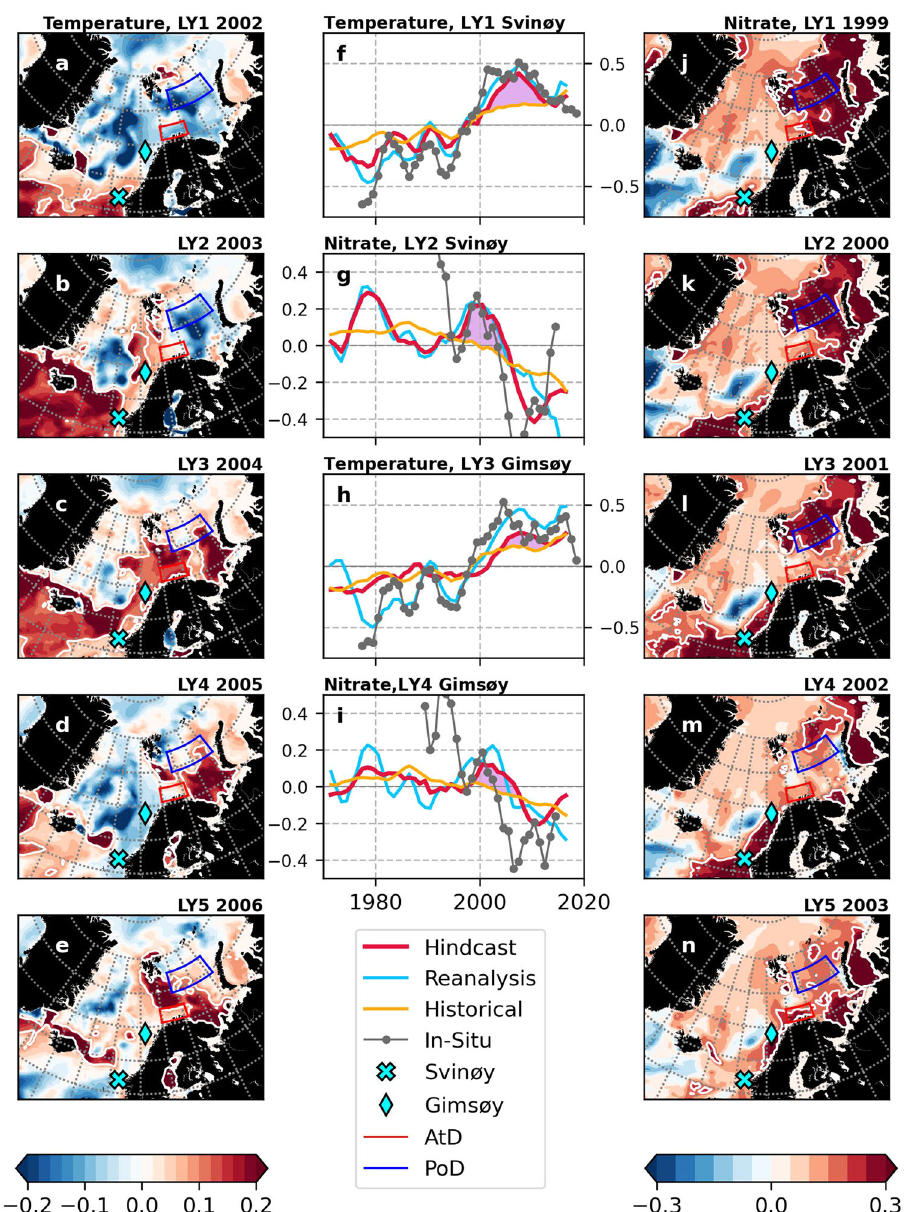
Fig. 3 Advective pathways. Maps showing the anomaly residual (hindcast minus historical) of 50 – 200 m annual mean temperature ( ∘ C) for lead years 1 – 5 ( a – e ) in the hindcast initialized in November 2001, and annual mean nitrate ( μ mol l − 1 ) for lead years 1 – 5 ( j – n ) for the hindcast initialized in November 1998. Time series of 50 – 200 m annual mean temperature and nitrate concentration, respectively, at the Svinøy ( f , g ) and Gimsøy ( h , i ) sections from in situ measurements (gray line with points), the historical simulation (orange), the reanalysis (blue) and the hindcasts at lead year 1 ( f ), 2 ( g ), 3( h ), and lead year 4 ( i ) (red). Purple shading marks the respective hindcasted temperature and nitrate anomalies that are discussed in the